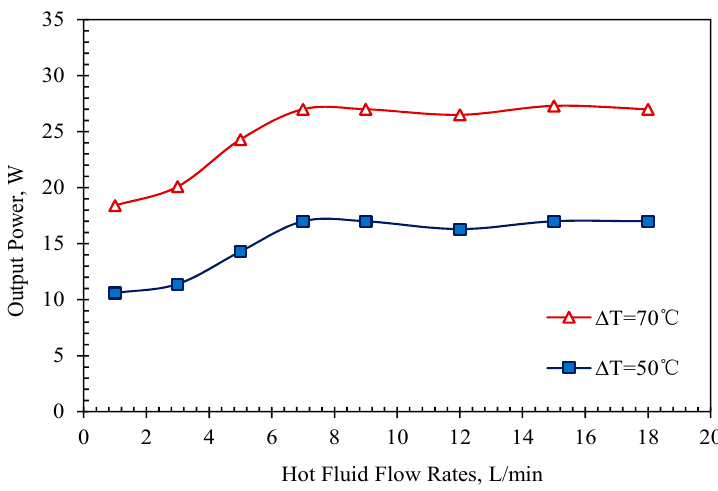
Figure 15. The effect of hot fluid flow rate on output power.